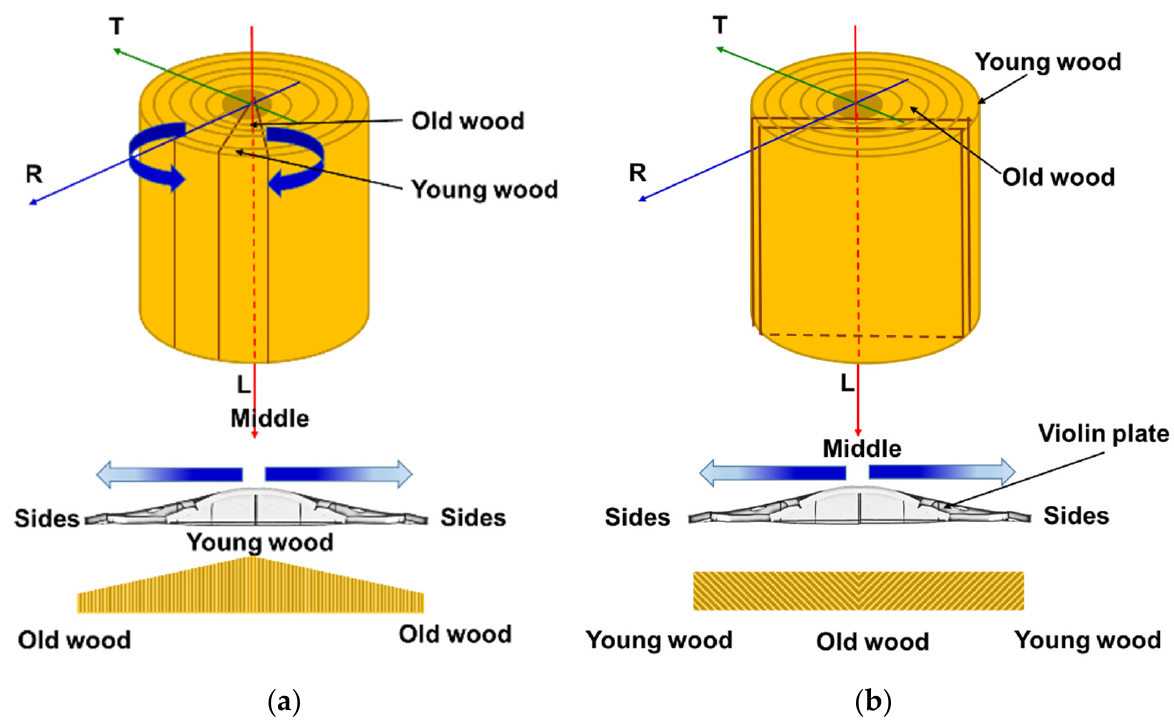
Figure 2. The main types of wood cuts for the violin: ( a ) quarter sawn; ( b ) live sawn.